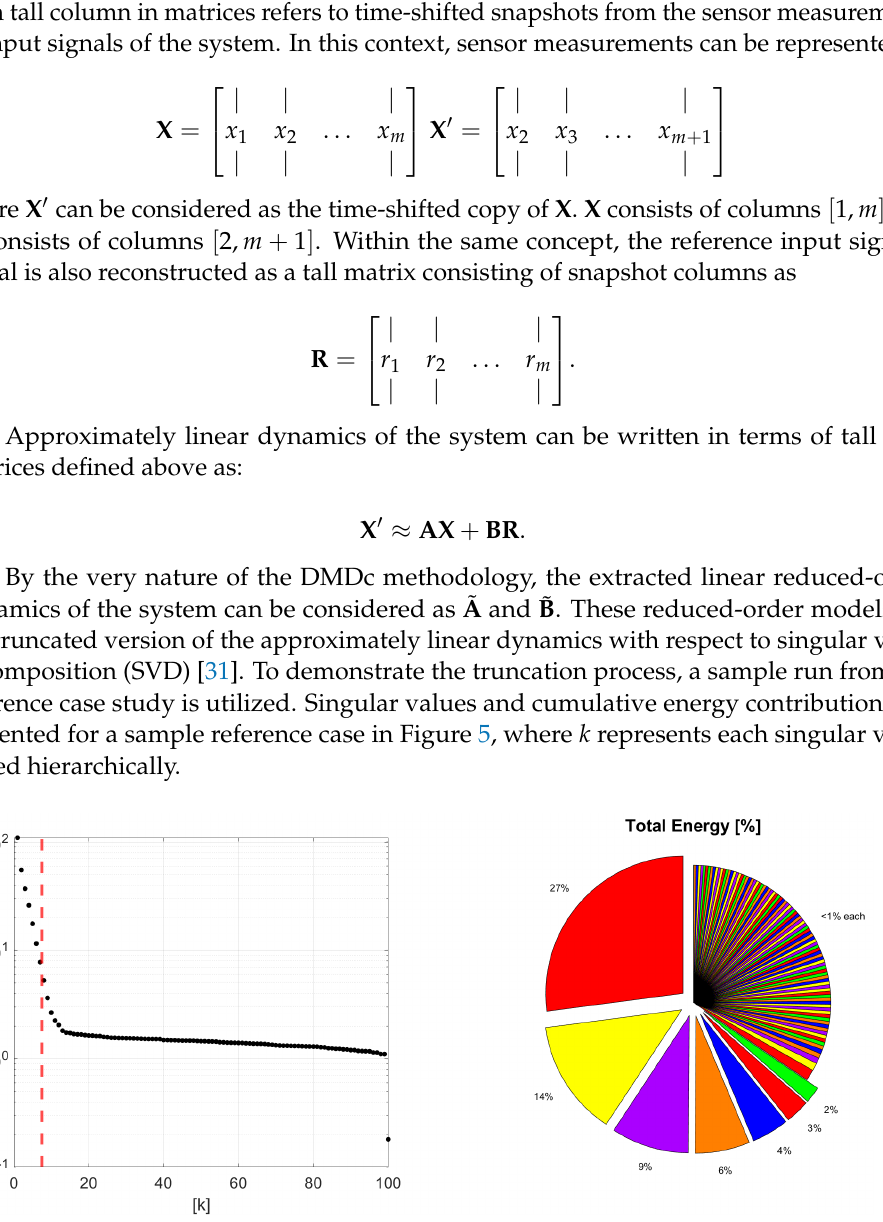
Figure 5. Singular values and cumulative energy contributions for a sample reference case, where the first 7 singular values contribute 65% of the total